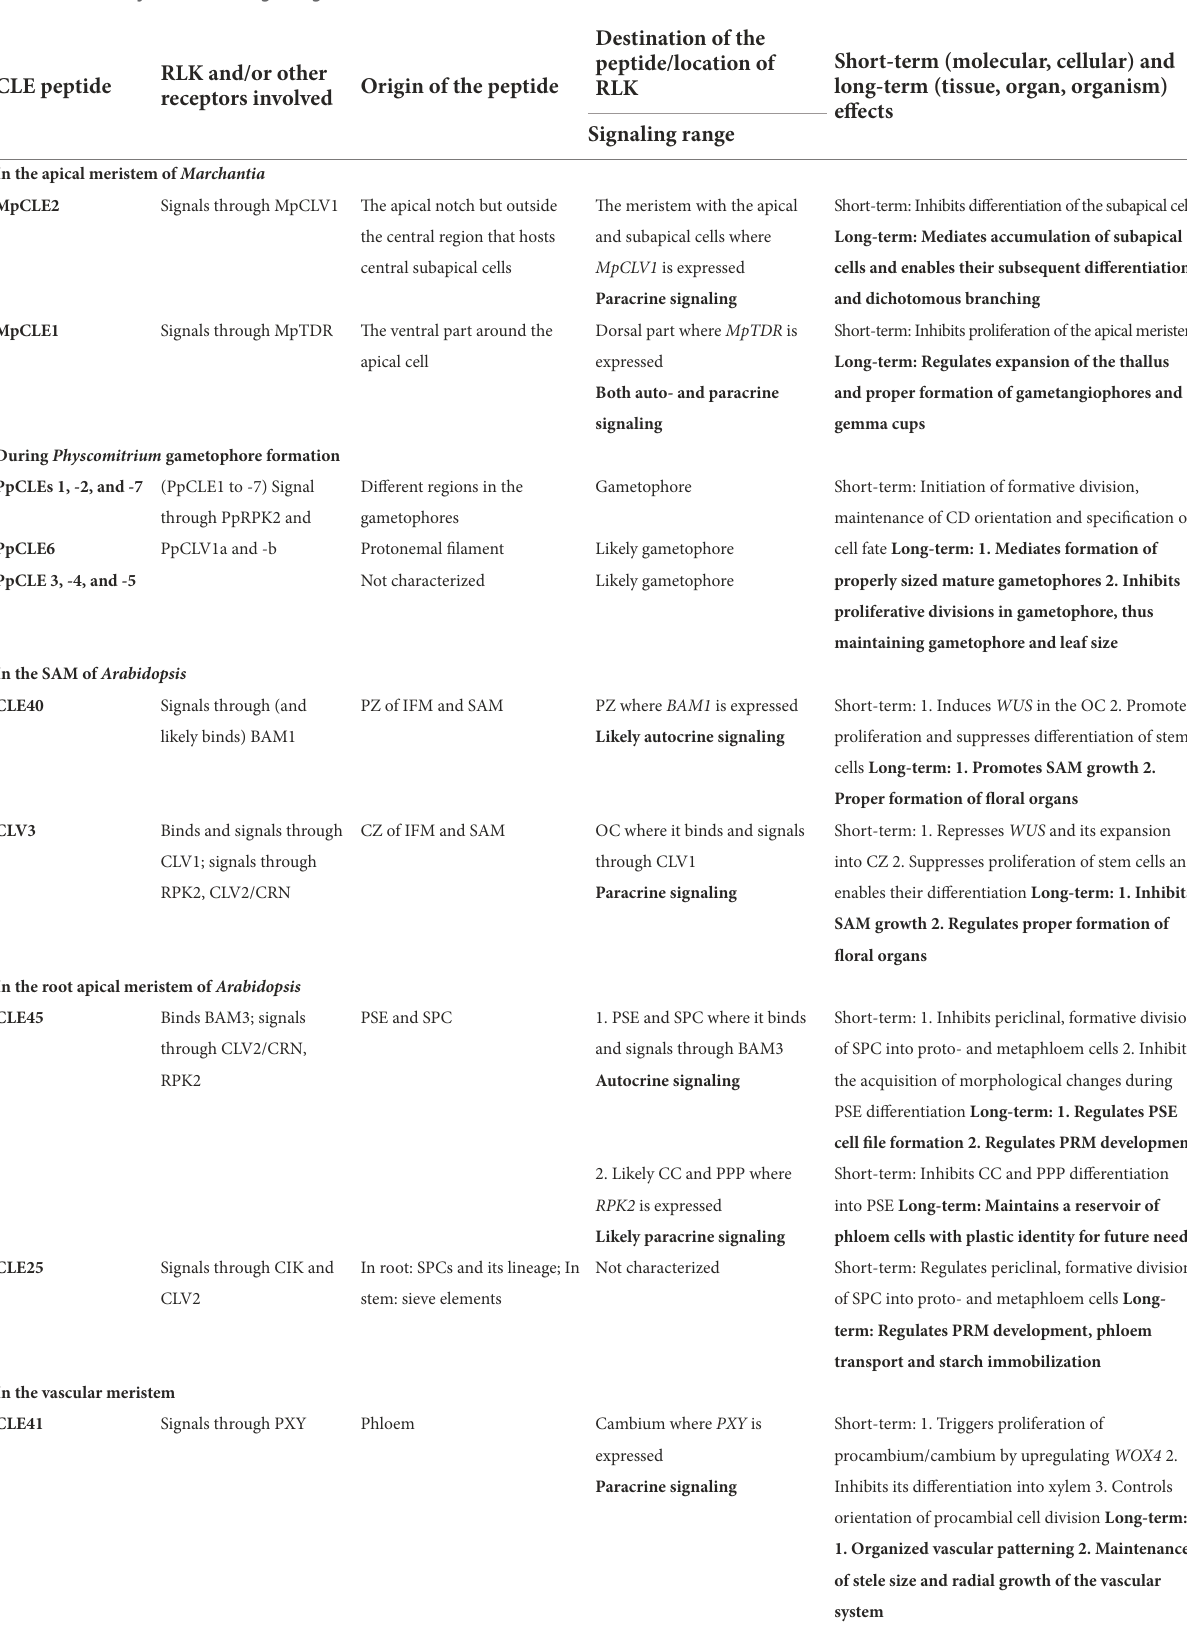
TABLE 1 Summary of CLE-RLK